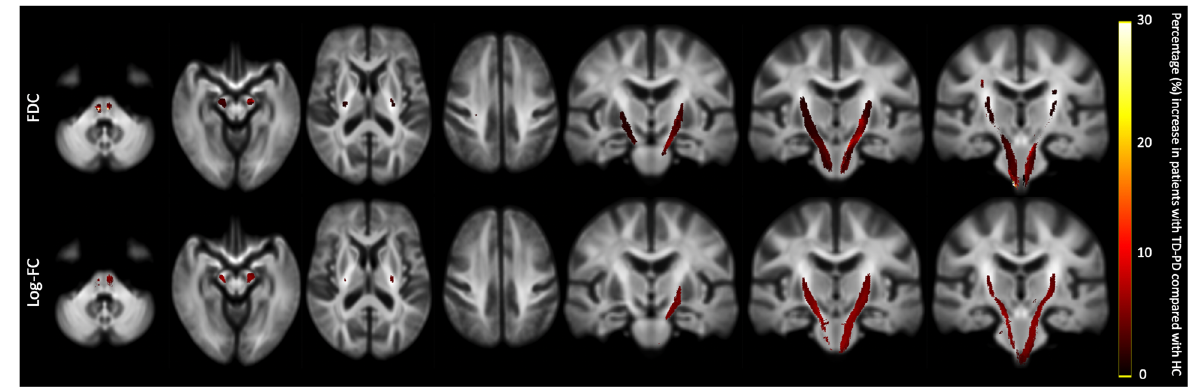
Fig. 1 Fiber tract-speci fi c signi fi cant FDC and log-FC increases in patients with TD-PD compared to HC. Streamline segments were cropped from the template tractogram to include only streamline points that corresponded with signi fi cant fi xels (family-wise error-corrected P < 0.05). Streamlines were colored by percentage effect increase of log-transformed FC and FDC in the TD-PD group compared with the HC group. FC fi ber cross section, FDC fi ber density and cross section, HC healthy controls, TD-PD patients with tremor-dominant Parkinson ’ s disease.